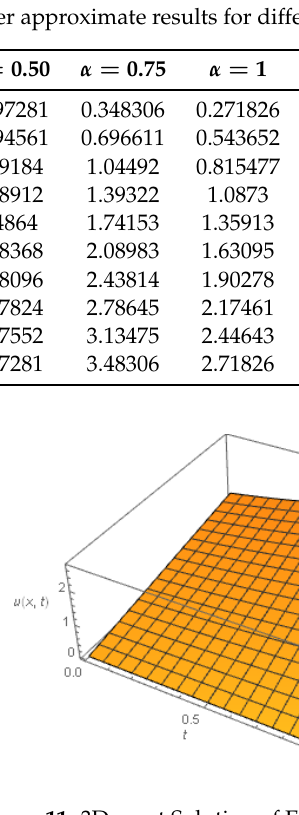
Figure4: Absolute error of example3 at